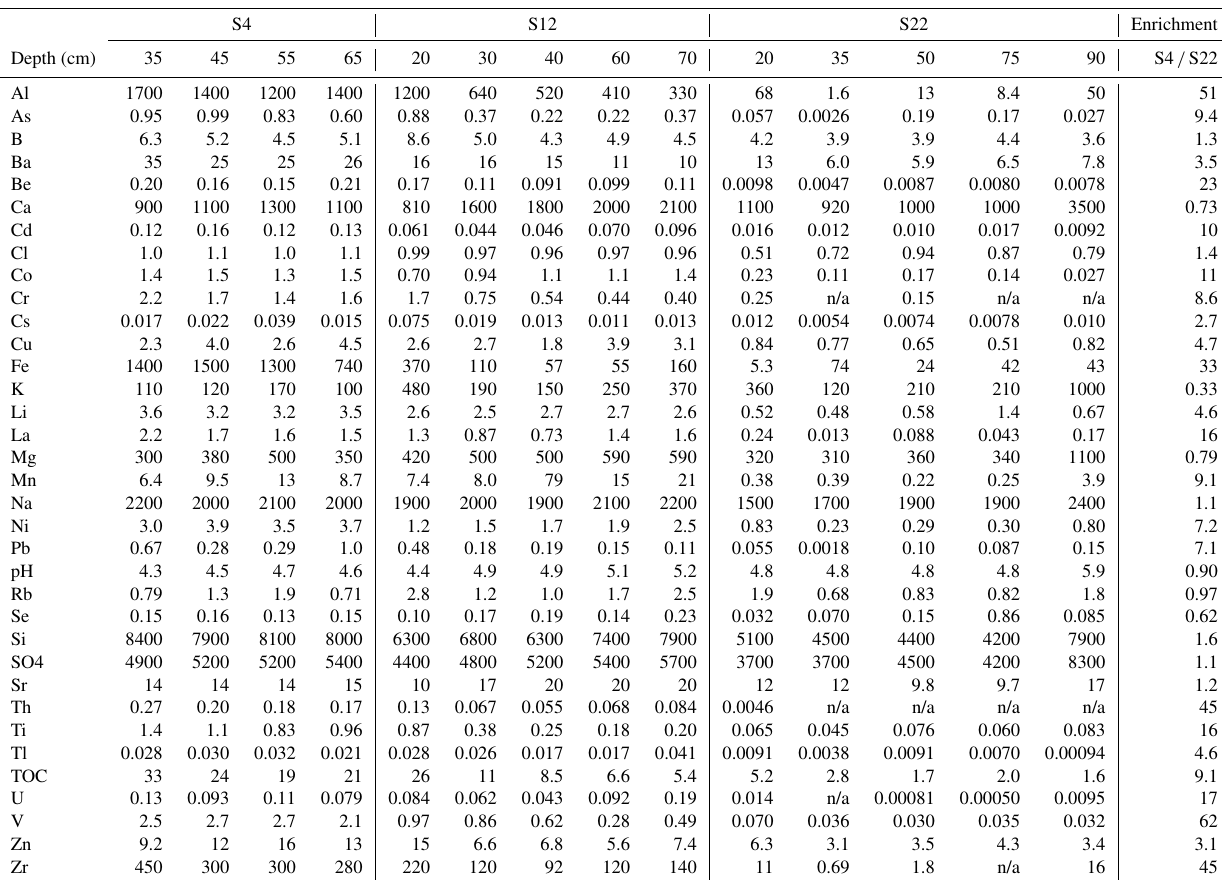
Table 1. Average element concentrations at different depths in the three investigated soil profiles. All concentrations are given in µgL − 1 except for TOC, which is given in mgL − 1 . The number of samples included in the averages varies from 1 to 10, depending on availability of soil water, detection limits etc. See Table S3 for corresponding relative standard deviations. The last column illustrates the enrichment in the riparian zone (the ratio between the average concentration in S4 and S22,